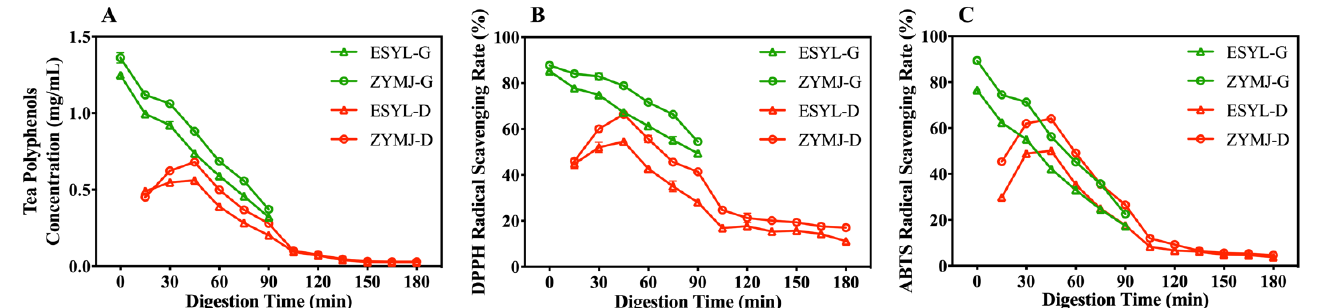
Figure 4. Changes in the tea polyphenol concentration ( A ) and antioxidant activity (DPPH ( B ) and ABTS ( C )) of the digesta at various stages during the simulated gastroduodenal digestion in vitro. Values are means ± SD from three independent triplicate experiments. G, simulated gastric digestion stage; I, simulated duodenal digestion